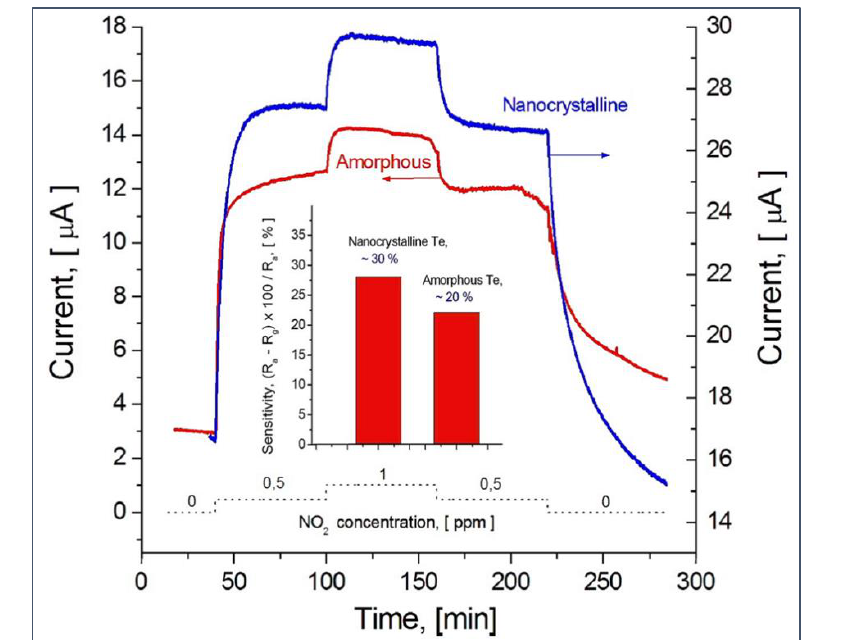
Figure 5. Transient characteristics of gas - induced current by exposure of tellurium thin films to various concentrations of NO at room temperature. Inserted diagram 2 shows a comparison of sensitivity to 1 ppm NO of a nanocrystalline film with an 2 amorphous one.